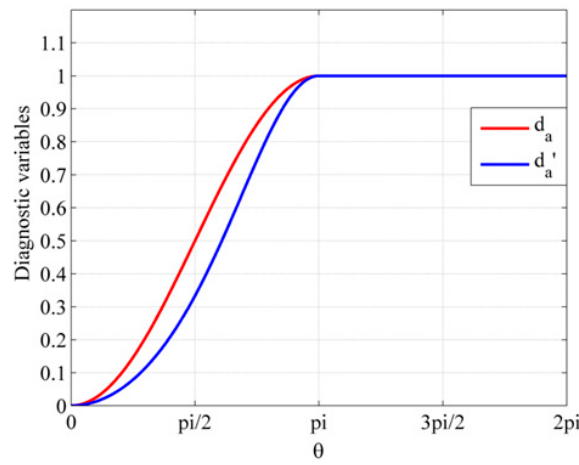
Figure 7. Comparison between the two diagnostic variables.